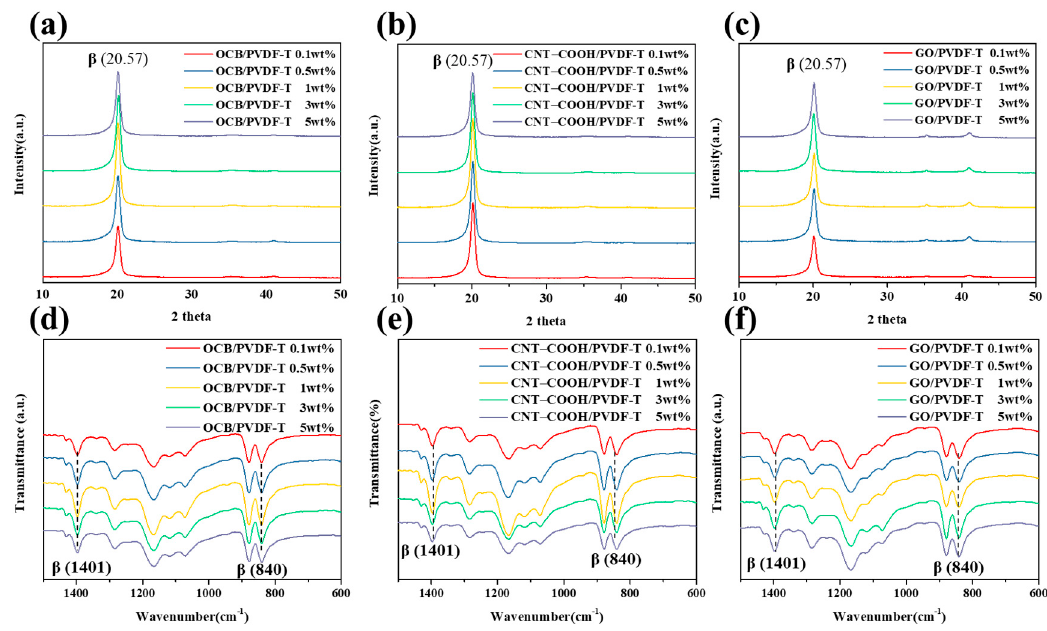
Figure 3. ( a – c ) XRD and ( d – f ) FTIR curves of PVDF-TrEE with di ff erent ratios of OCB, CNT–COOH, Figure 3. ( a − c ) XRD and ( d − f ) FTIR curves of PVDF-TrEE with different ratios of OCB, CNT–COOH, and and GO.